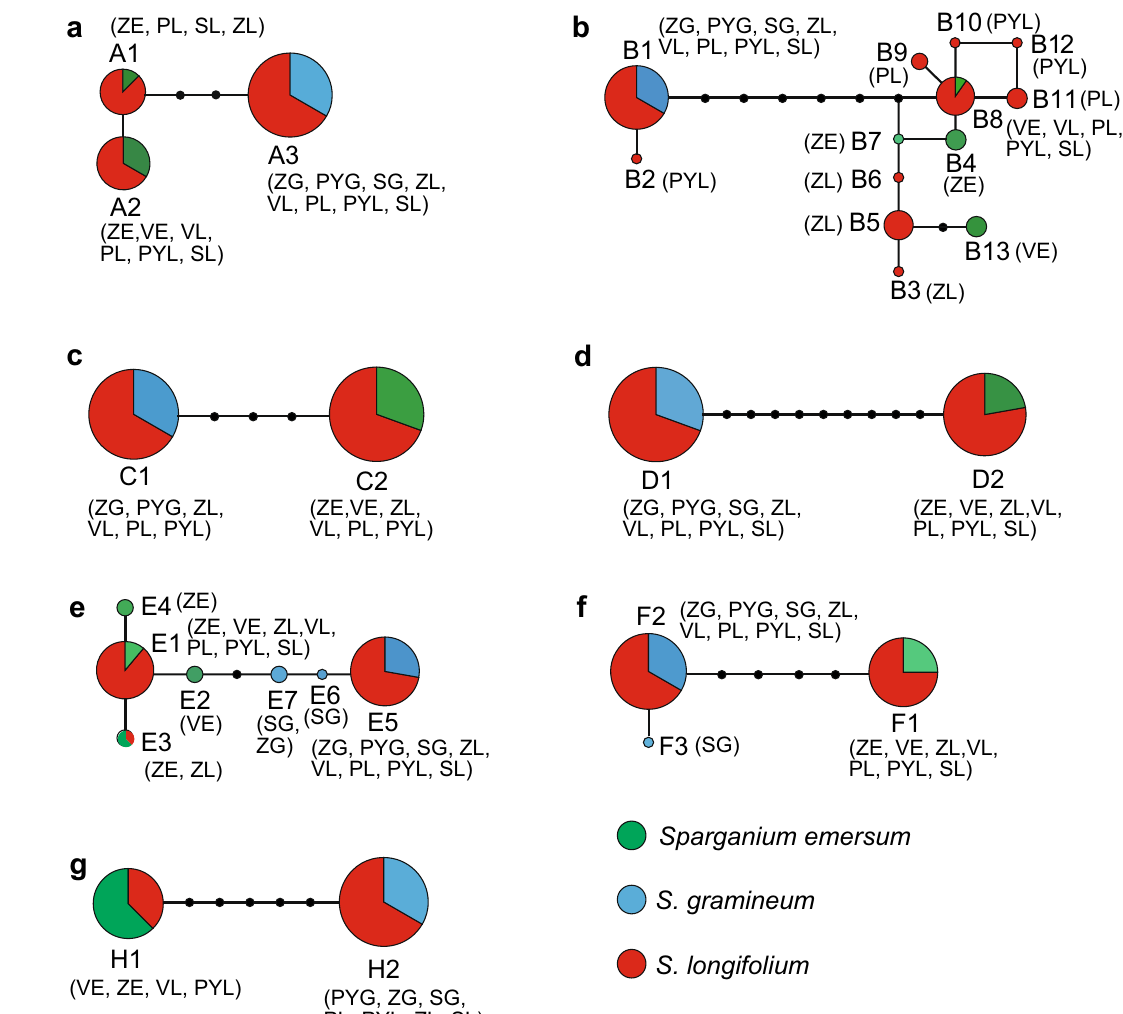
Figure 1. Haplotype networks of six nuclear loci Tran05 ( a ), Tran57 ( b ), Tran59 ( c ), Tran66 ( d ), Tran83 ( e ), and Tran93 ( f ), and cpDNA fragment trn H- psb A ( g ). Node size is proportional to the number of each haplotype. Small black circles represent unsampled or hypothetical haplotypes. Population codes indicated beside haplotypes are the same as Table